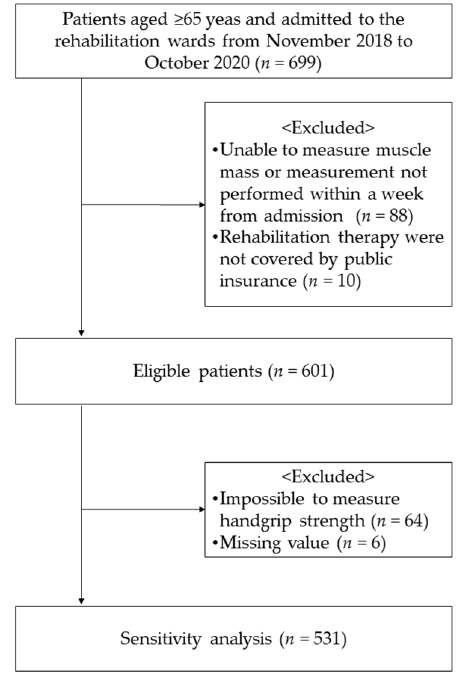
Figure 1. Flowchart of selection for study participants.